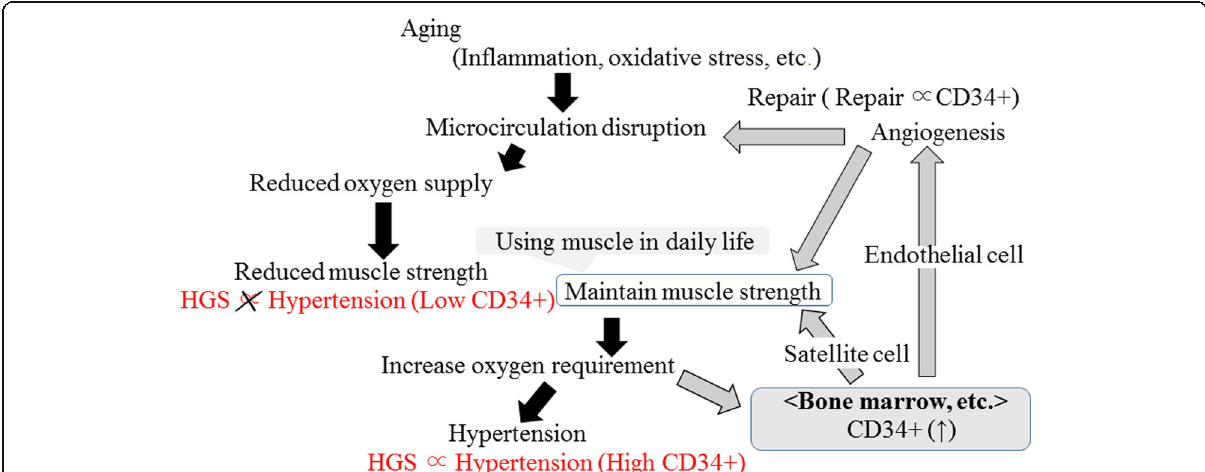
Fig. 1 Possible mechanism underlying the association between handgrip strength and hypertension. Associations shown in red were observed in the present study. HGS handgrip strength, CD34+ CD34-positive